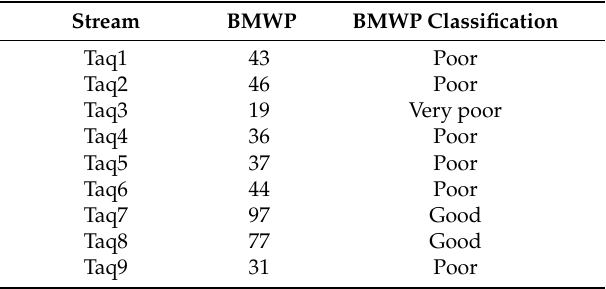
Table 4. Results of Biological Monitoring Working Party (BMWP) [21] applied to nine streams of the Taquaruçu Grande river basin, State of Tocantins, Brazil.